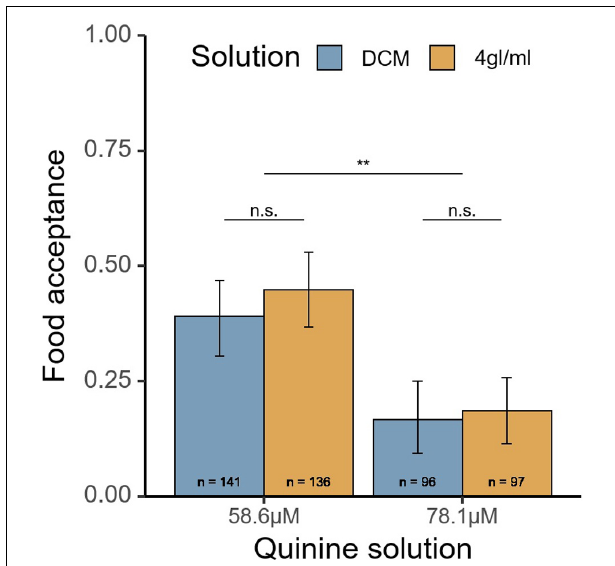
FIGURE 3 | Food acceptance of the quinine solution in experiment 3 after passing a runway treated with pheromone (4 gl/ml) or DCM solvent (DCM). Food acceptance of 1 would correspond to uninterrupted drinking in the first 3 s. Quinine solution corresponds to X µ M of quinine in 0.5 M sucrose syrup. 4 gl/ml, 4 pheromone glands per milliliter DCM. ** p < 0.01; n.s., not